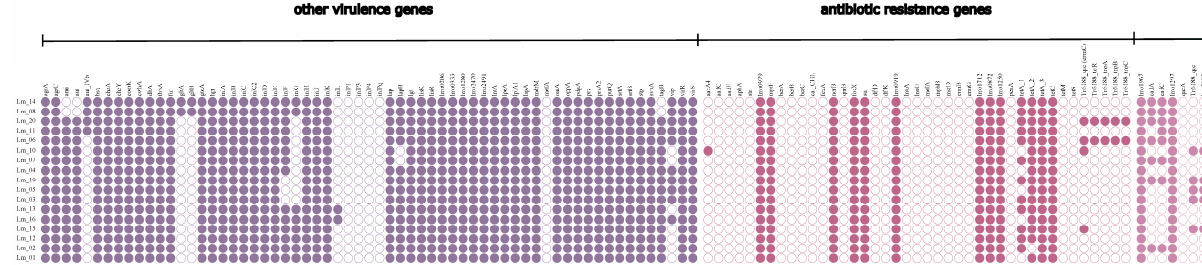
Figure 4. Occurrence of virulence and resistance among L. monocytogenes isolates.